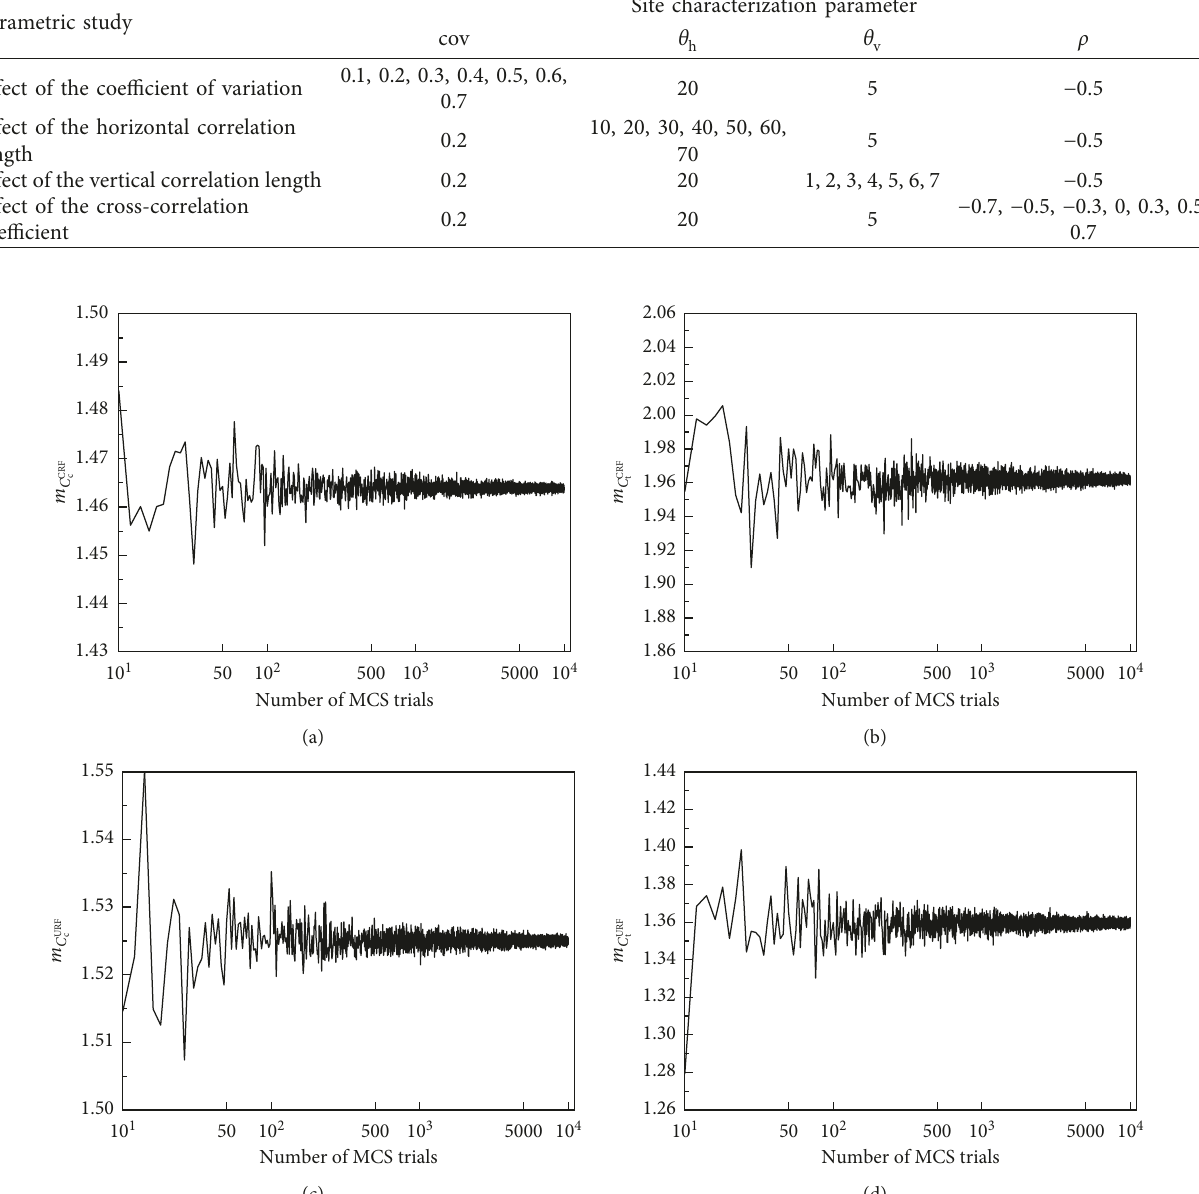
m m m C URF c , and (d) C URF t C CRF c , (b) C CRF t , (c)